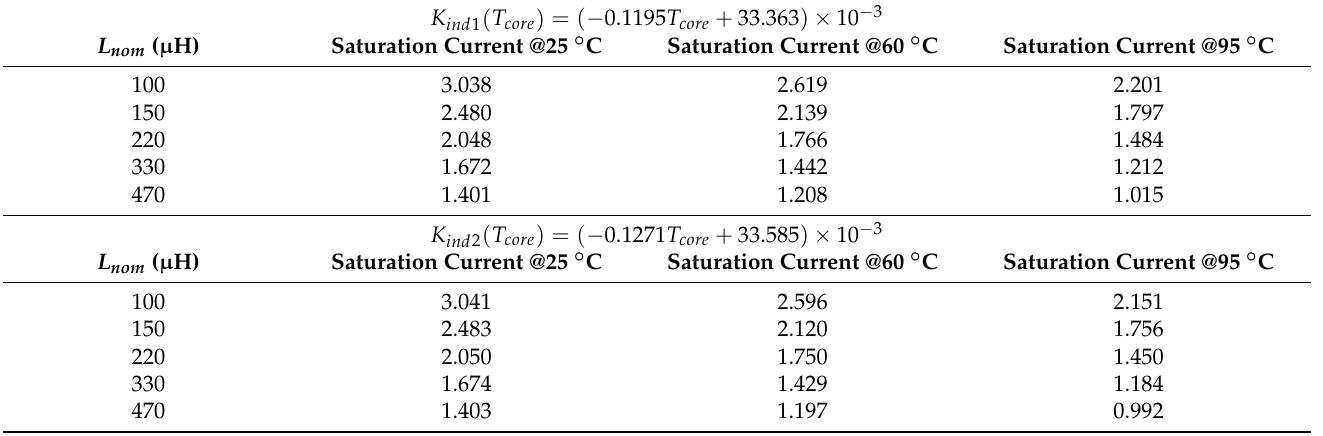
Table 1. Saturation currents at different temperatures with K derived from inductor 1 (100 µ H) or from inductor 2 (330 µ